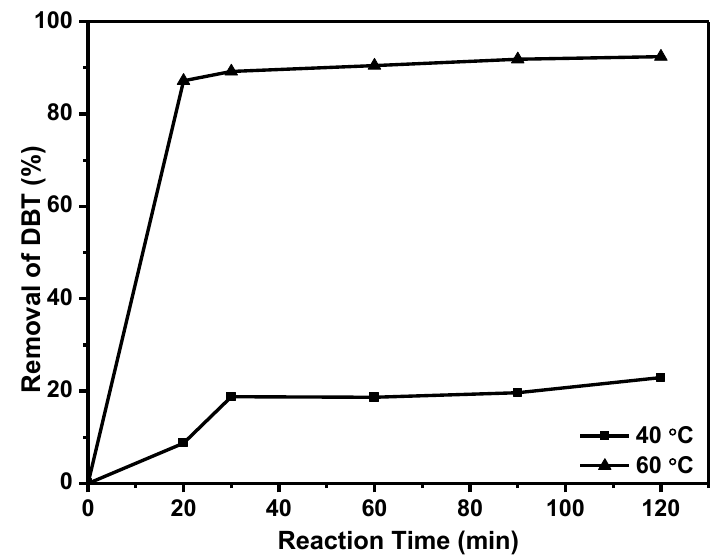
Figure 6. Reaction temperature effect on catalytic reactivity of 50%Ti-MIL-101-550.